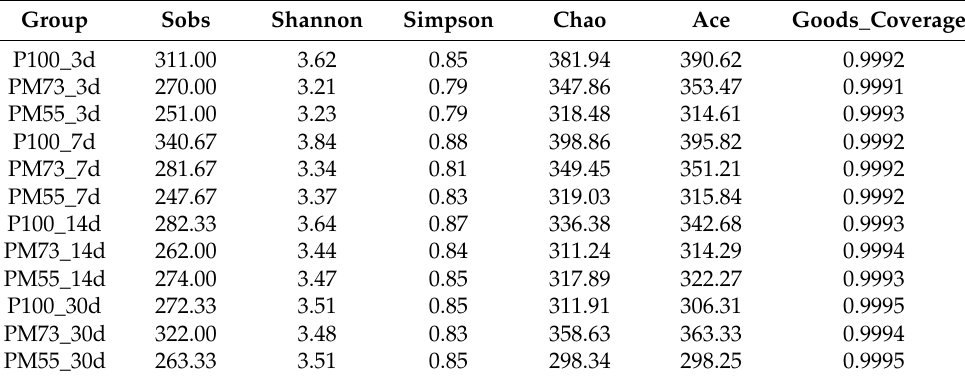
Table 6. Alpha diversity of the bacterial community for hybrid Pennisetum and mulberry leaves silages.